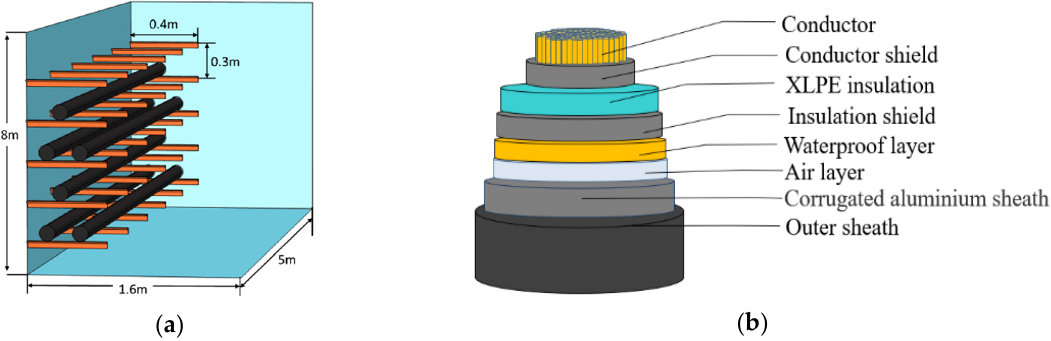
Figure 2. A schematic diagram of the Yanzhong line cable trench structure: ( a ) the cable distribution diagram; ( b ) the schematic diagram of a 110 kV cable. Table 1. T he physical dimensions and material parameters of the 110 kV cable.